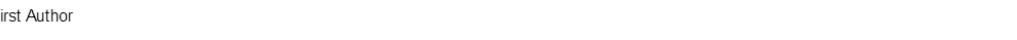
Figure 6. Estimated impact/severity of an adverse event (defined as quality of living; QoL) caused by contraindica- tions/cautions.